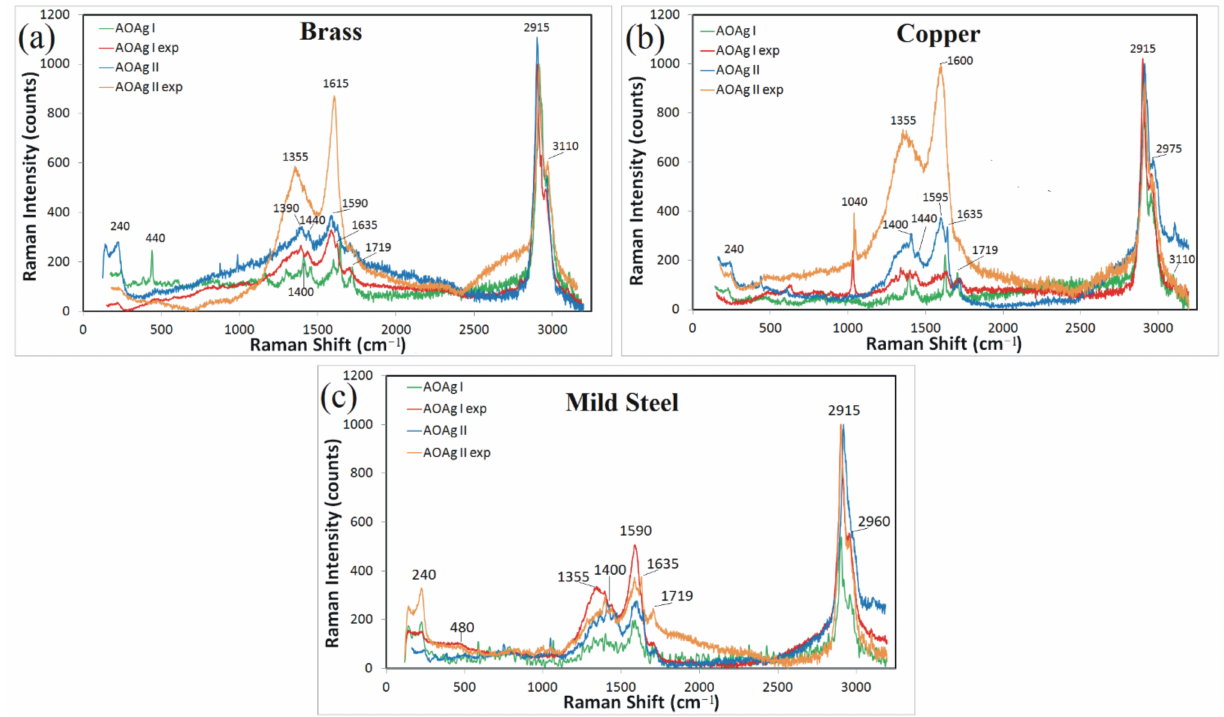
Figure 6. Raman spectra recorded before and after exposure to a pollutant (NO 2 ) were recorded for the Ag NPs doped coatings deposited on: ( a ) brass plates, ( b ) copper plates, and ( c ) mild steel